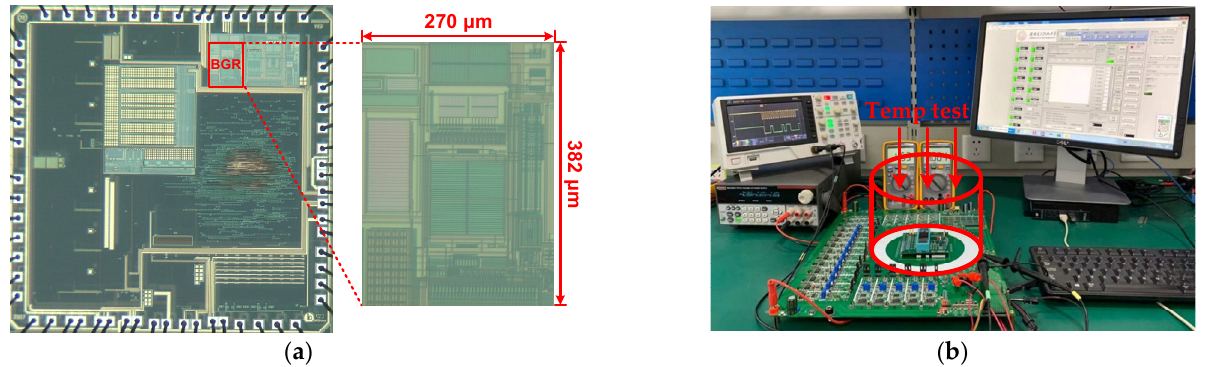
Figure 10. ( a ) Chip microphotograph of the proposed BGR circuits; ( b ) Photo of the BMIC test plat- form.